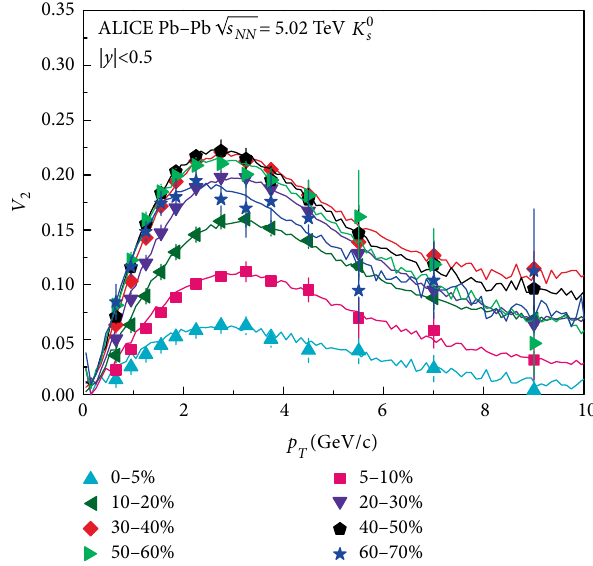
of 𝐾 0 for a given 2 (𝑝 푇 ) 푠